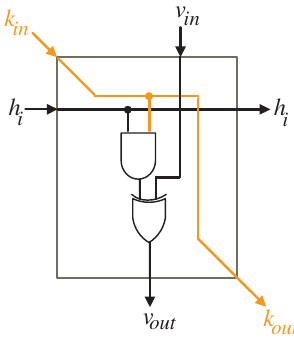
Figure 6. PE logic